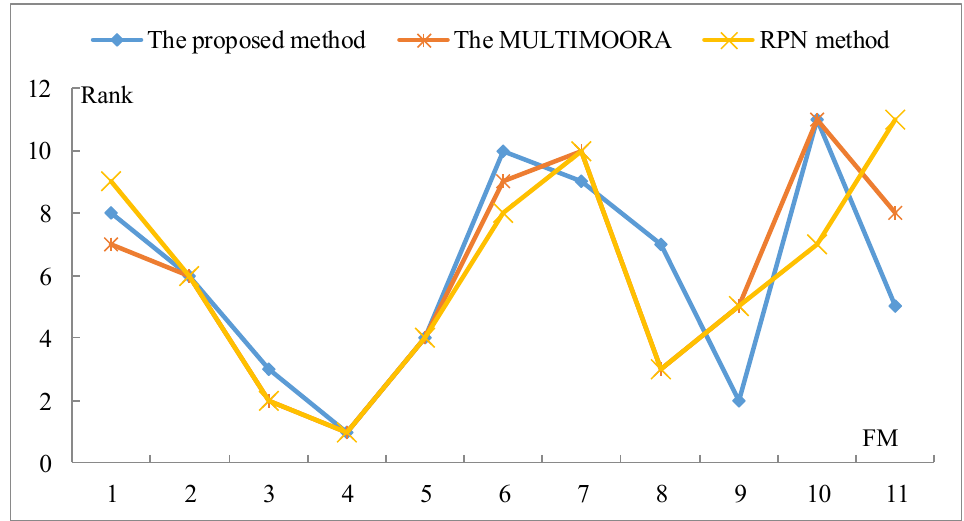
Figure 3. Results of comparison analysis.